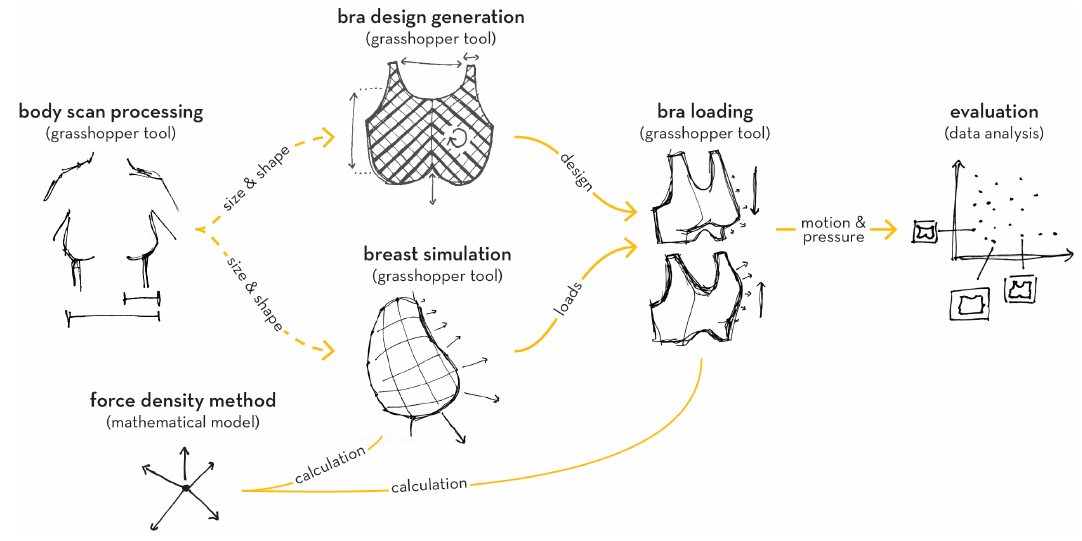
Figure 2. Diagram of